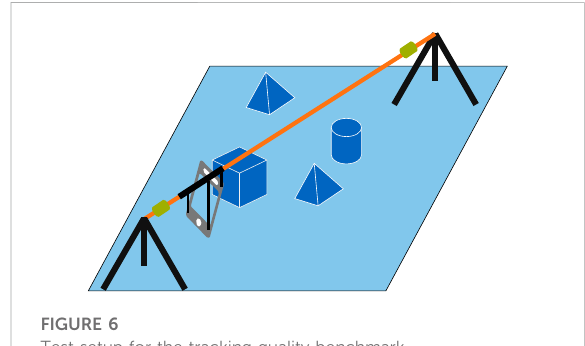
FIGURE 6 Test setup for the tracking quality benchmark.